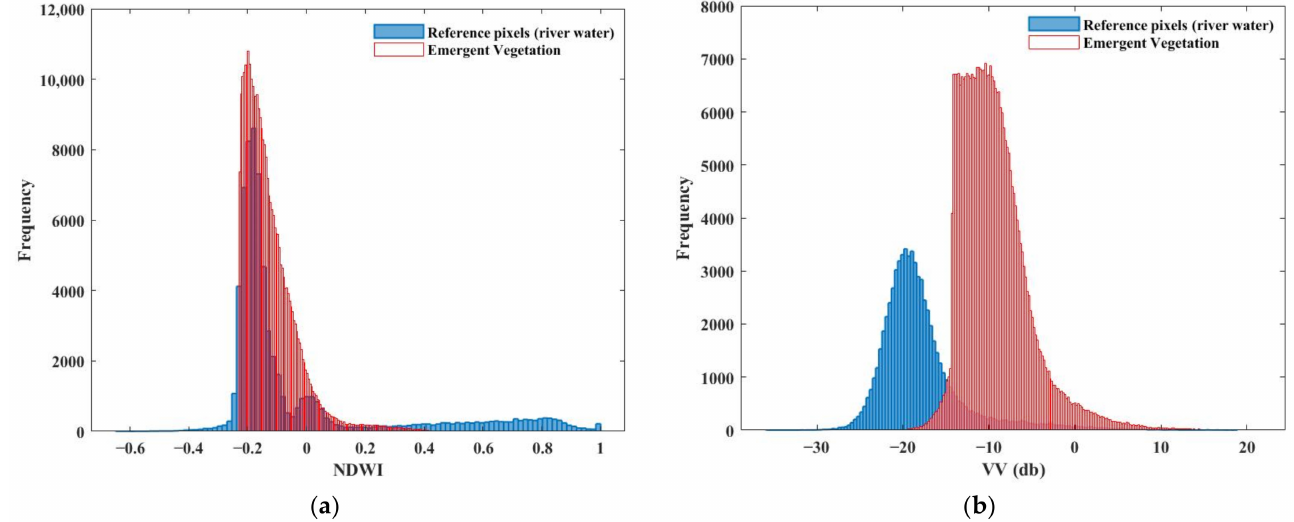
Figure 15. Signatures of emergent vegetation vs. reference water body observed during the 2020 flooding event: ( a ) NDWI from S2/MSI data and ( b ) VV backscatter (in dB) from S-1 SAR